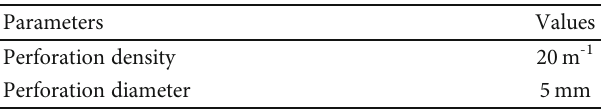
Figure 6: Comparison of in fl ow rate distribution by the new coupling model, Penmatcha ’ s model, and Ouyang ’ s model. Table 2: Parameters of completion with uniform perforation density.